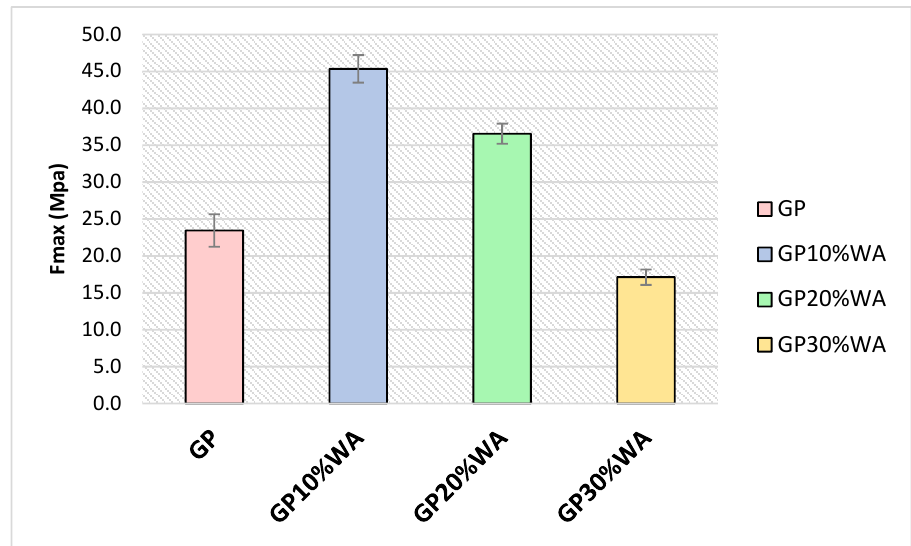
Figure 8. Mechanical compressive strength results.